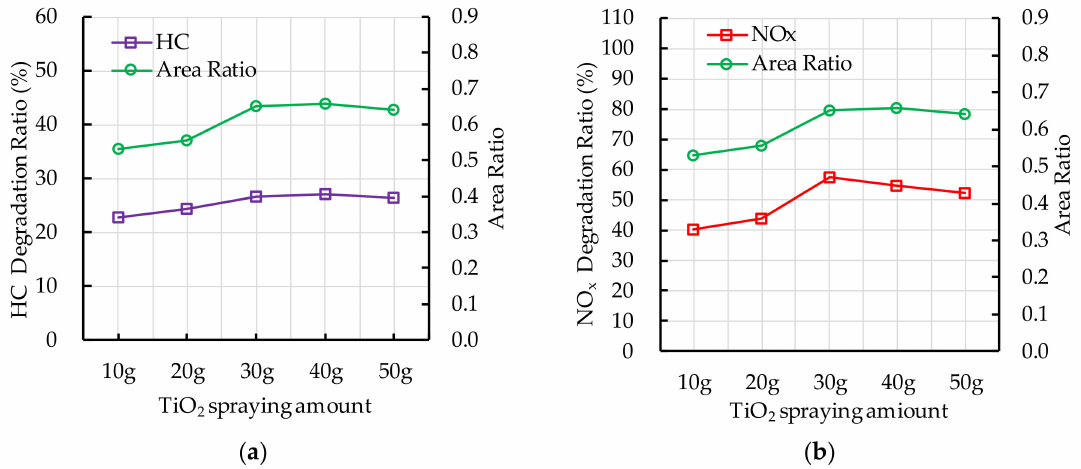
Figure 20. E ff ect of TiO 2 spraying amount on photocatalytic degradation and area ratio: ( a ) HC; ( b ) NO x .